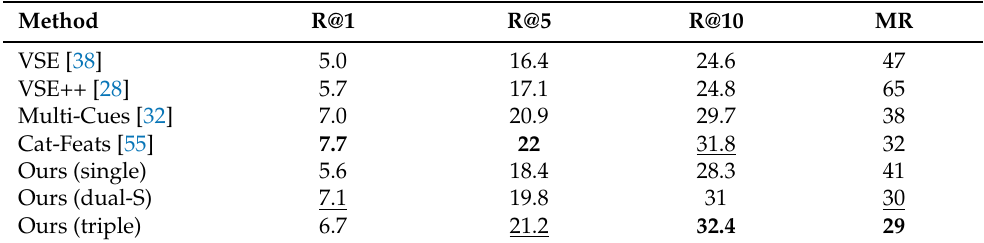
Table 1. The results of sentence-to-video retrieval task on the Microsoft Research Video to Text dataset (MSR-VTT) dataset. The bold and underlined results represent the first- and the second-best,